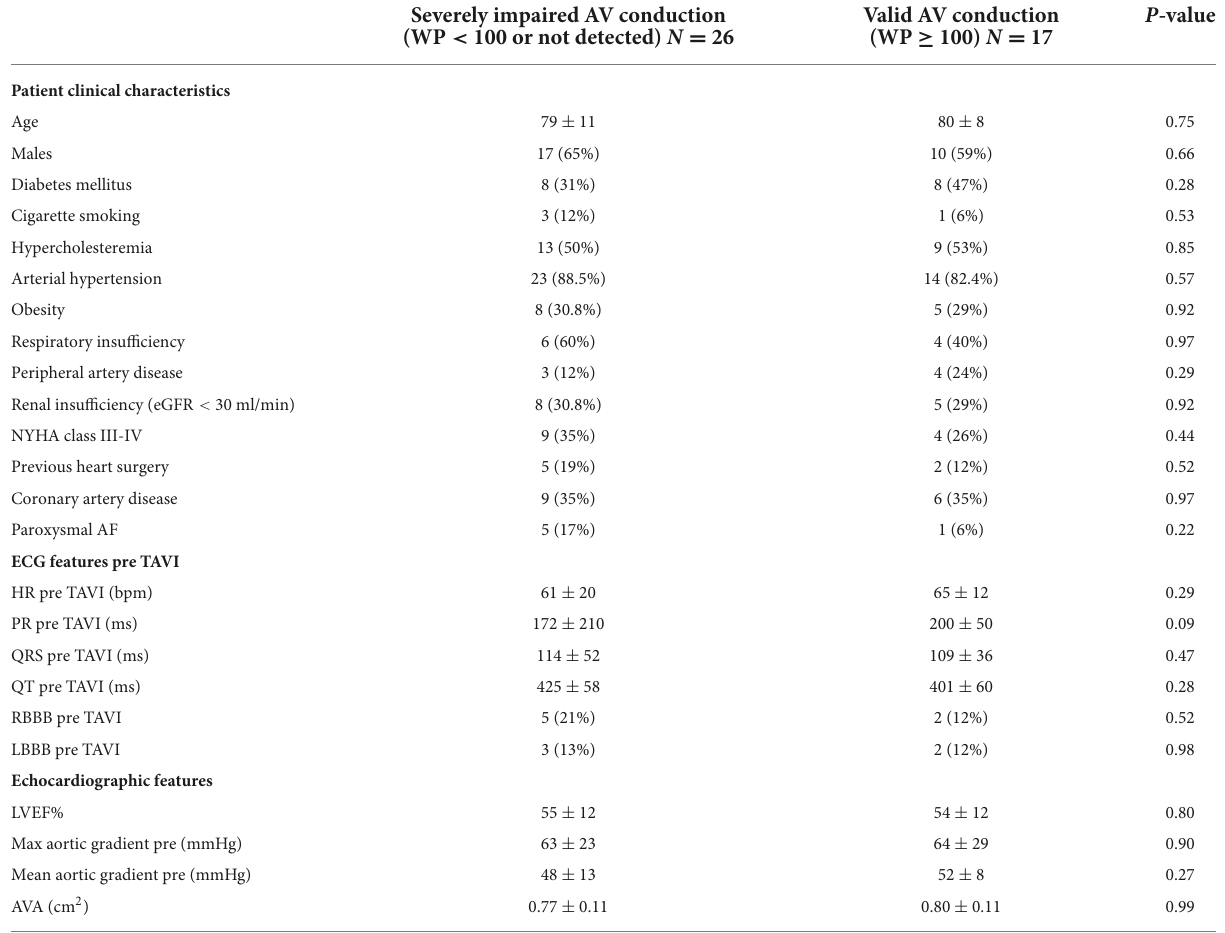
TABLE 1 Clinical, ECG and echocardiographic